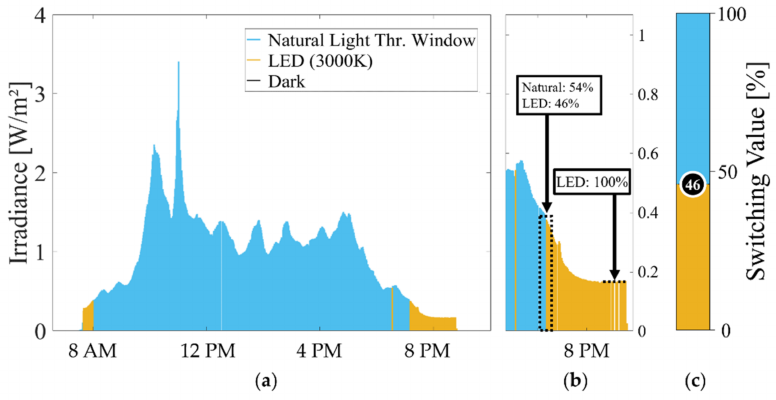
Figure 10. ( a ) Classes recognized for a day with mixed light sources using Fine KNN method, associated with the R data configuration; ( b ) Switching moment between natural light and LED light classes; ( c ) Switching ratio value between those two